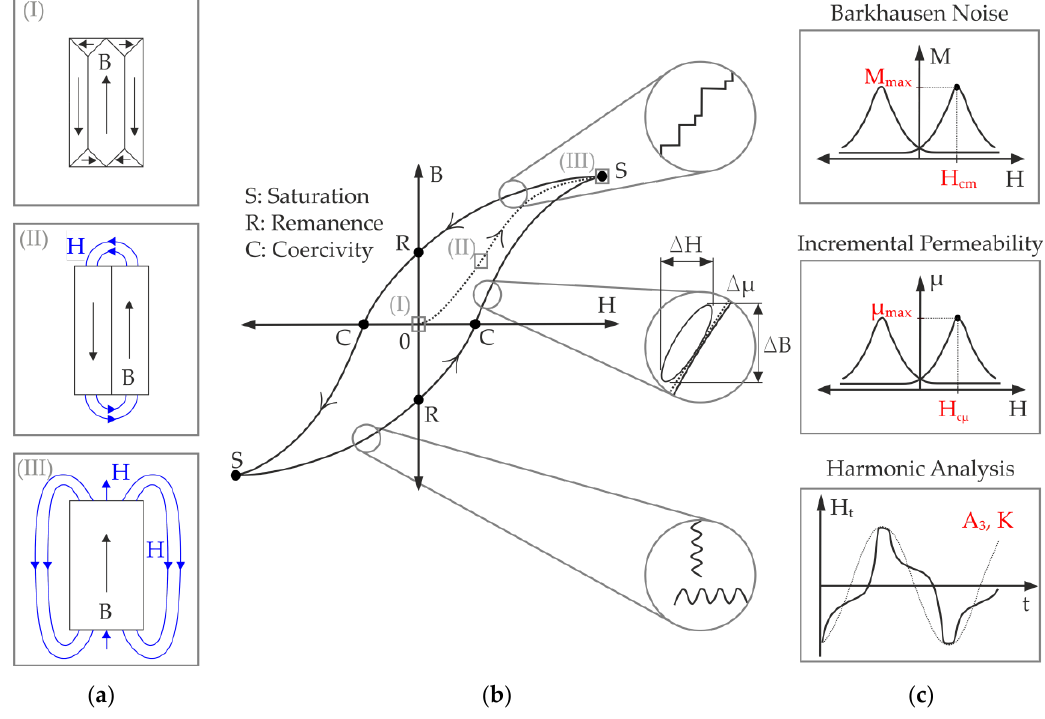
Figure 2. Magnetization of ferromagnetic materials: ( a ) evolution of magnetic domains; ( b ) hysteresis loop; ( c ) profiles of micromagnetic analysis techniques.